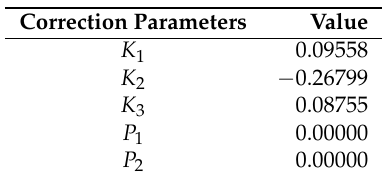
Table 1. Correction parameters of the lens distortion for Brown’s distortion model on Kinect v2 provided by the